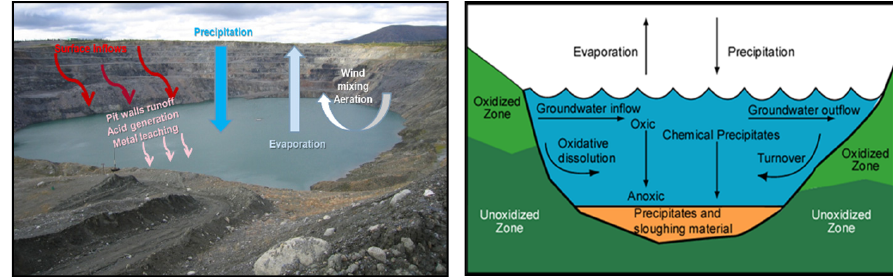
Figure 1. Modified conceptual model of pit lakes [1].